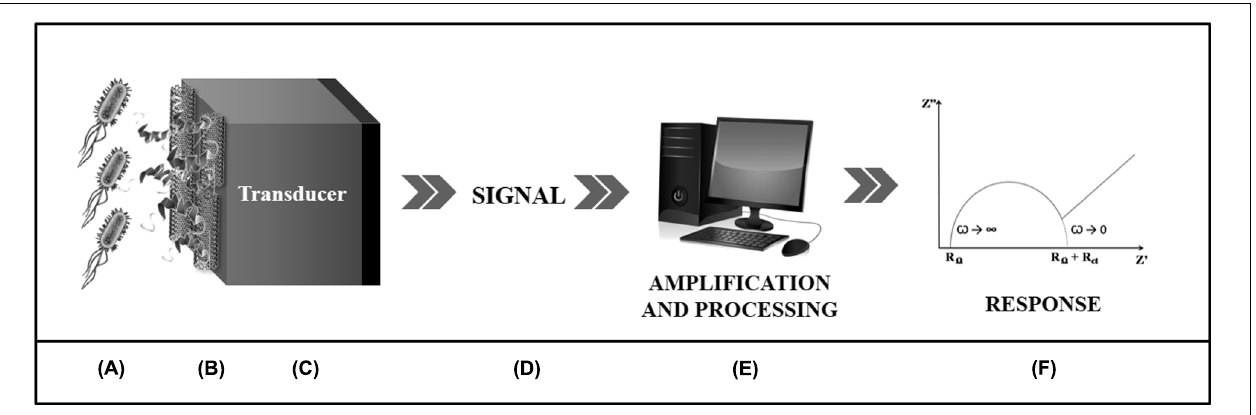
FIGURE 2 | Schematic presentation of an electrochemical biosensor. The detection of the analyte (A) is performed through a biological component (B) associated to a transducer (C) .This is responsible for converting the